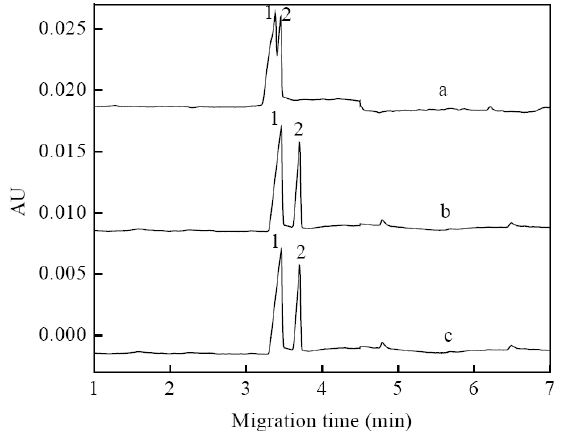
Figure 7. Effect of 18-crown-6 ether on the separation between K + and NH 4+ . Electrolyte: 12 mM imidazole, 5 mM malic acid, 20% D2O (v/v); 18-crown-6 ether (a) 0.5 mM; (b) 1.0 mM; (c) 1.5 mM; pH 4.25. Injection conditions and time are the same as in Fig.1. 1. NH 4+ ; 2. K + .